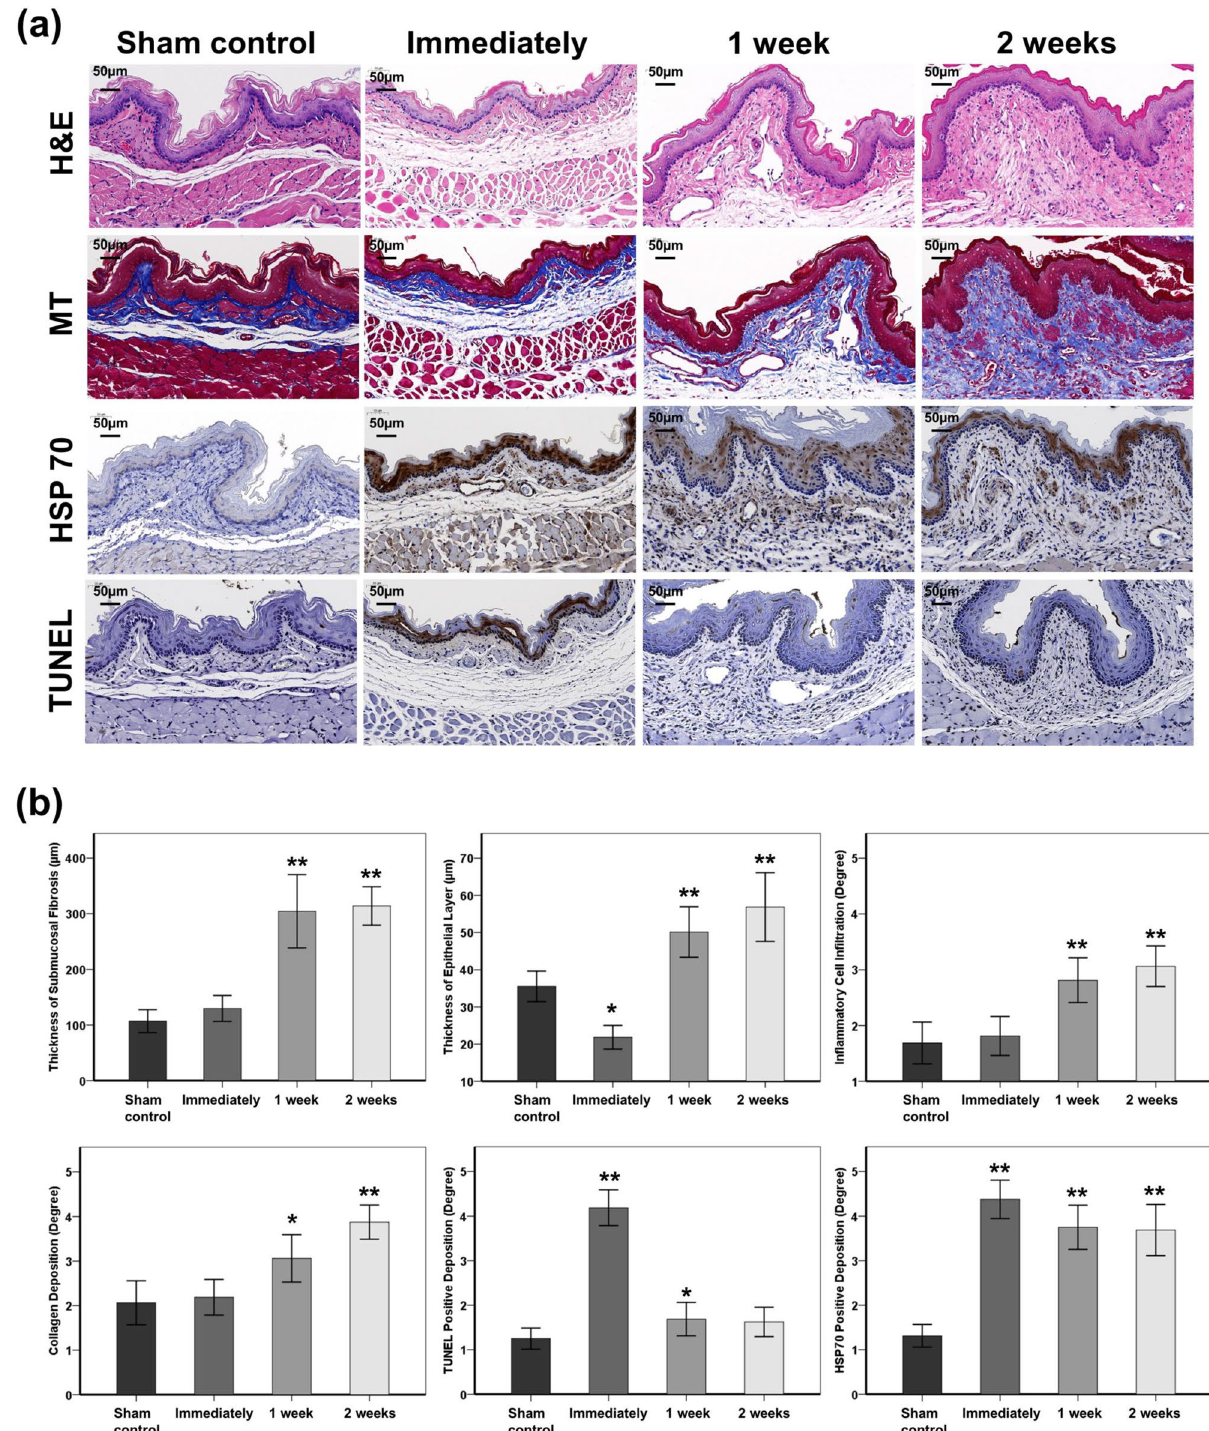
Figure 5. Representative microscopic images and serial histological findings at the indicated time points after radiofrequency (RF) ablation via the stent-based monopolar RF electrode (SE). ( a )Representative microscopic images of hematoxylin & eosin-, Masson’s trichrome-, heat shock protein 70 (HSP70)-, and terminal deoxynucleotidyl transferase mediated dUTP nick and labeling (TUNEL)-stained tissue slides. ( b ) Graphs of the histologic findings indicating serial changes to the thicknesses of the submucosal fibrosis and epithelial layers, the degrees of inflammatory cell infiltration, collagen deposition levels, and TUNEL and HSP 70 positivity. * p < 0.05, ** p <